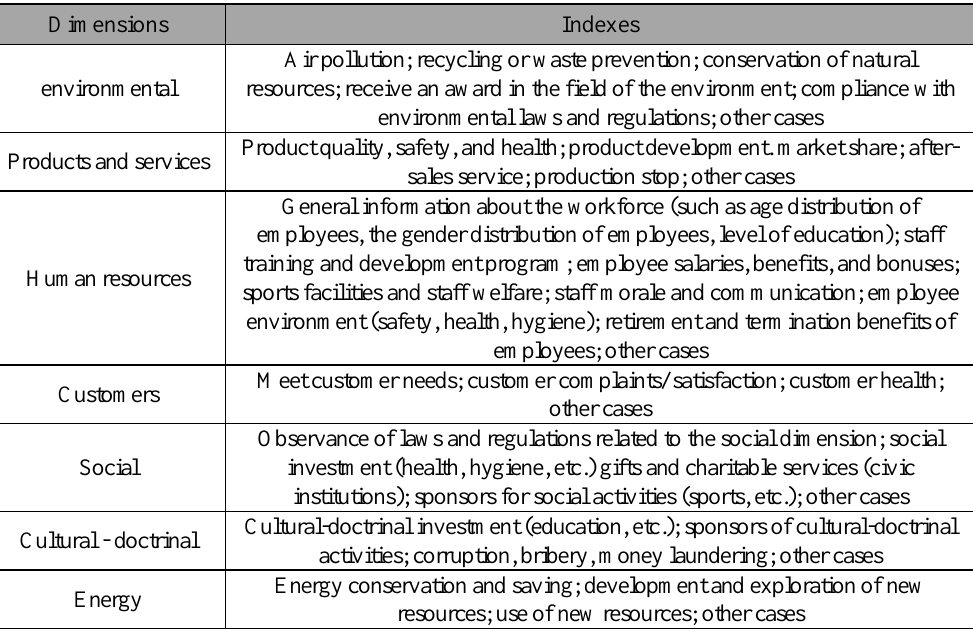
Table 3. Measurement of social responsibility